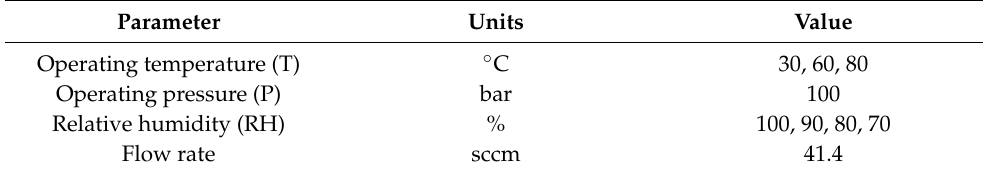
Table 2. Operating conditions of the electrochemical hydrogen compressor.